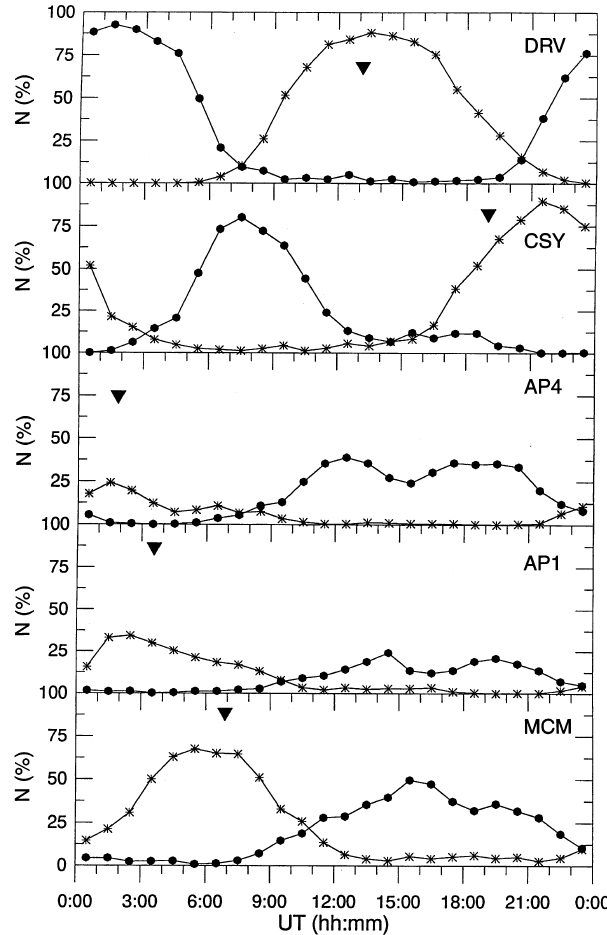
Fig. 4. Percentage of relative contribution from each station to ALS- 80 ( d ) and AUS-80 (*) separately for each UT hour. One minute resolution values are considered for ALS-80 and AUS-80. The black triangles indicate the time of local geomagnetic midnight at each